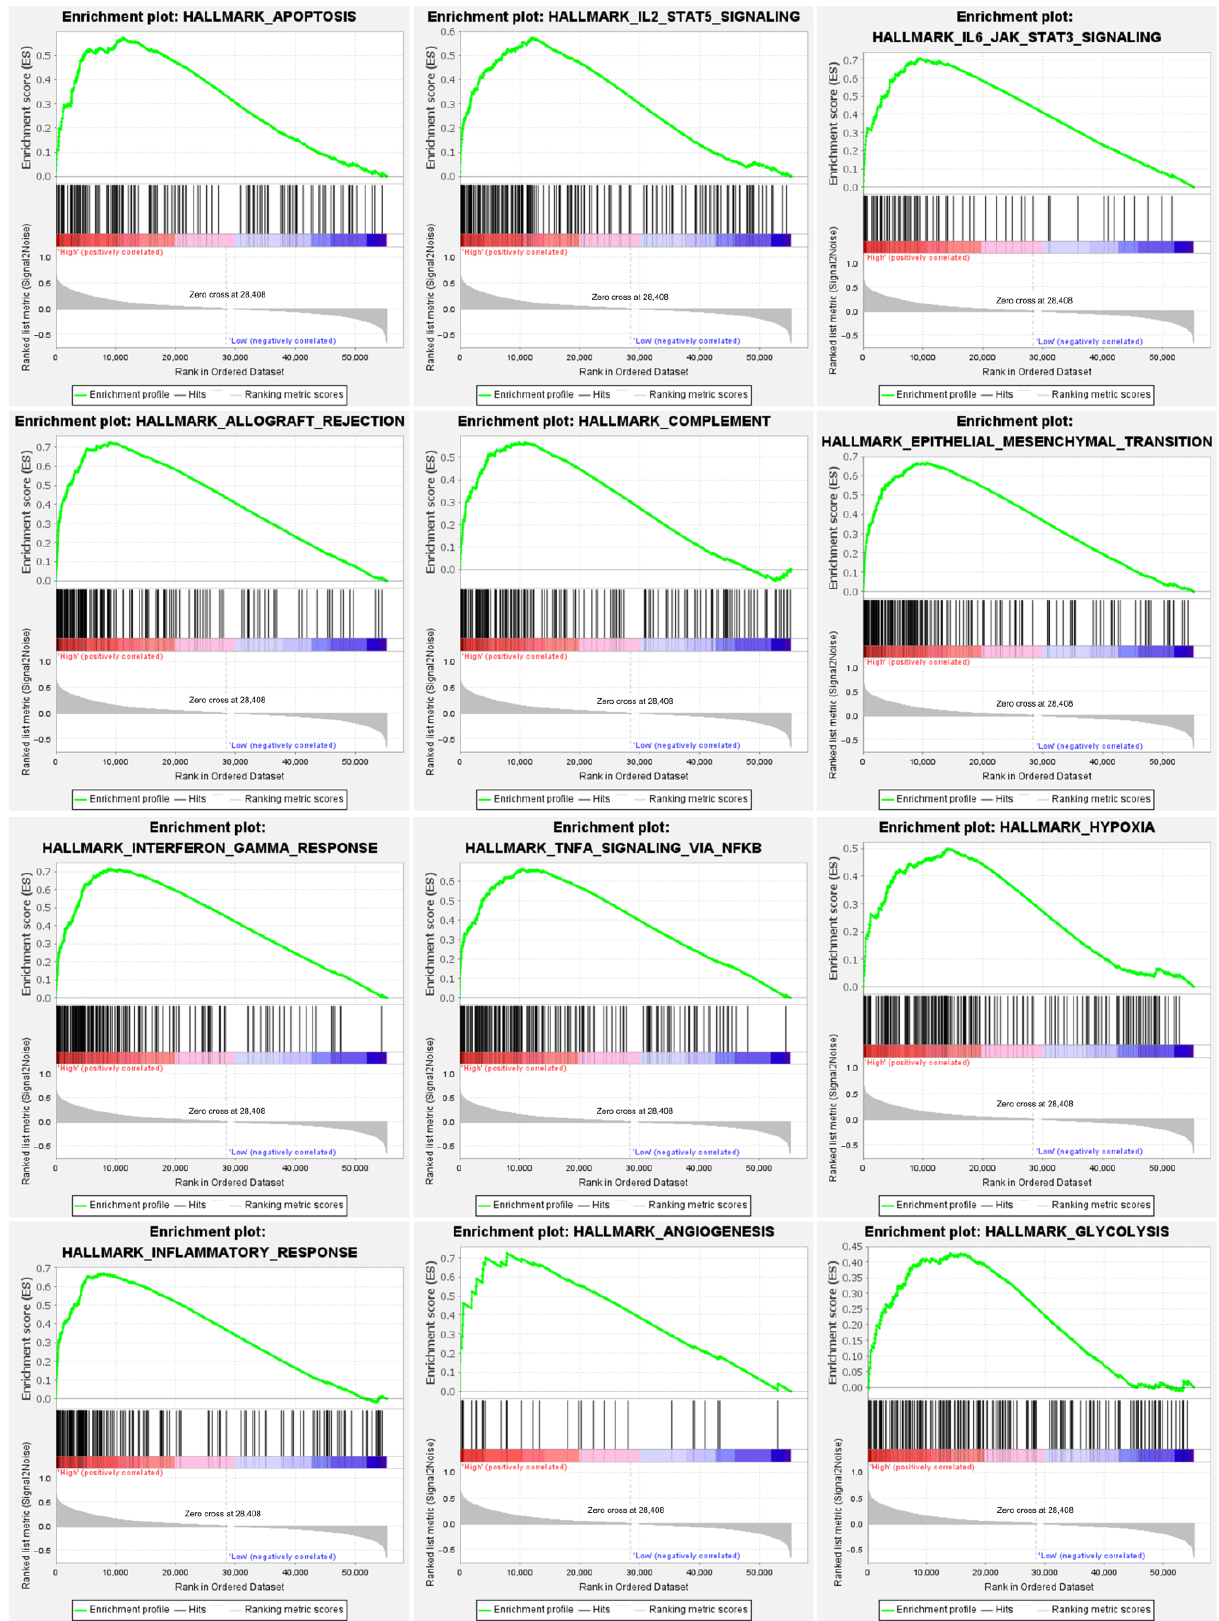
Figure 7. The GSEA analysis of APOL4 in